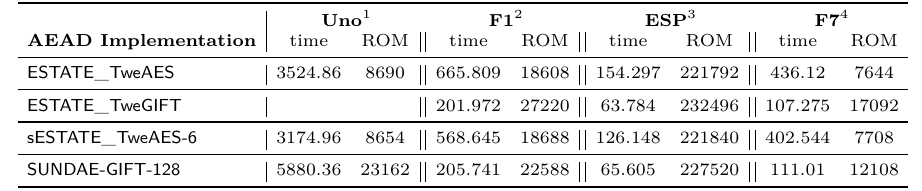
Table 13: Summary of time and ROM usage for round 2 candidates based on ESTATE and SUNDAE . Time is in microseconds and ROM size is in